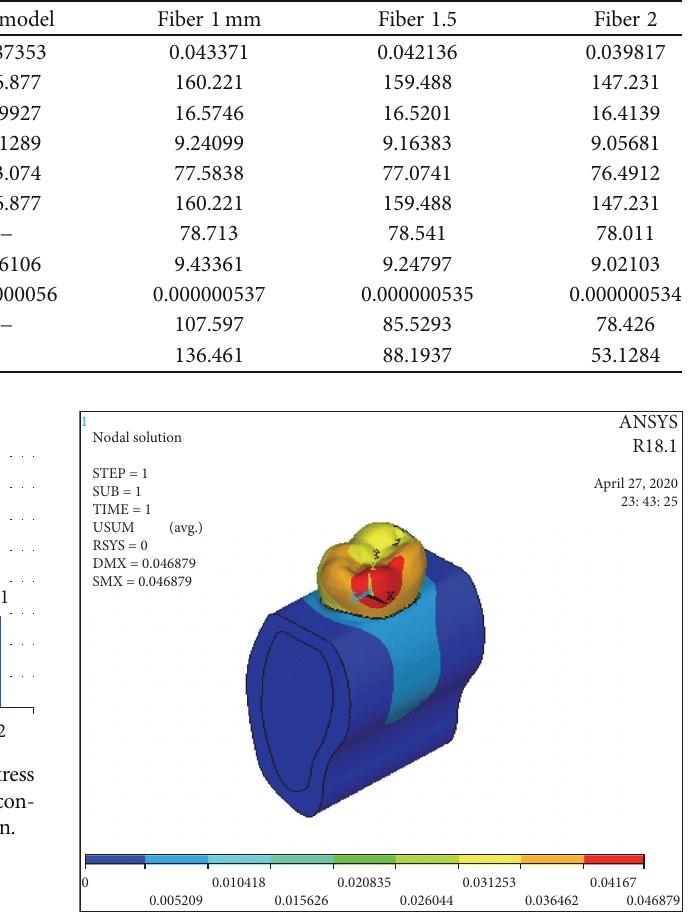
T ABLE 3: Stress and deformation comparison for all models.